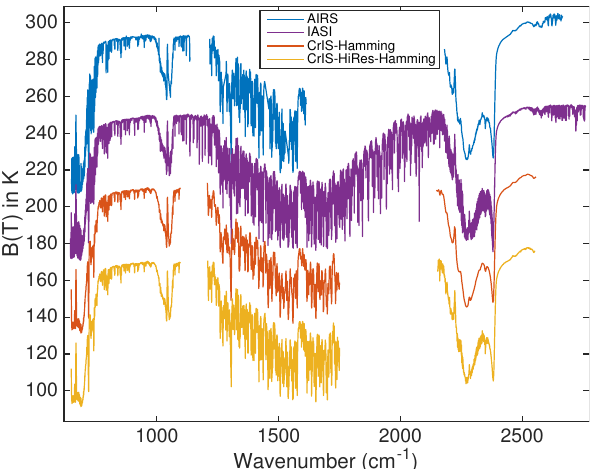
Figure 1. Sample BT spectra for the instruments that will contribute to the CHIRP product. Only AIRS is shown on a correct BT scale, the others are offset. Times when CrIS operates in NSR mode (denoted CrIS-Hamming here) are not included in